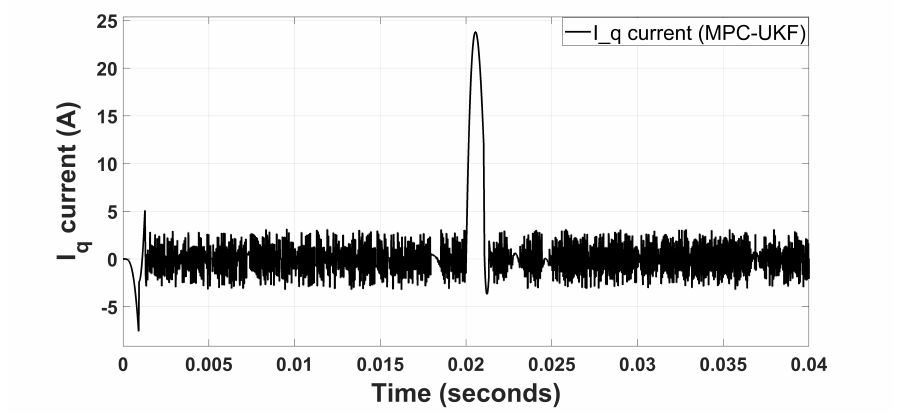
Figure 9. Feedback current for MPC-UKF.